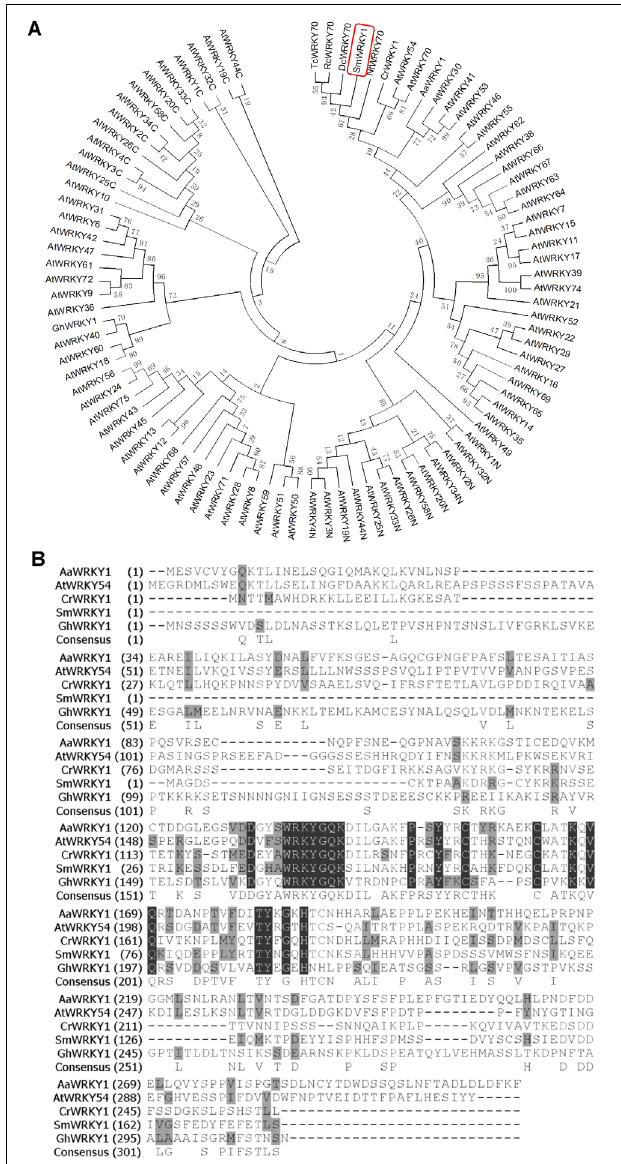
FIGURE 1 | (A) Multiple alignment of SmWRKY1 with related WRKY proteins from other plant species. Black boxes indicate identical residues; gray boxes indicate identical residues for at least three of the sequences. (B) Phylogenic tree analysis of SmWRKY1 and WRKY TFs from Arabidopsis thaliana , Artemisia annua , Catharanthus roseus , Nicotiana tabacum , etc. Phylogenic tree was constructed on MEGA6.0 by using neighbor-joining method and the bootstrap values were obtained for 1000